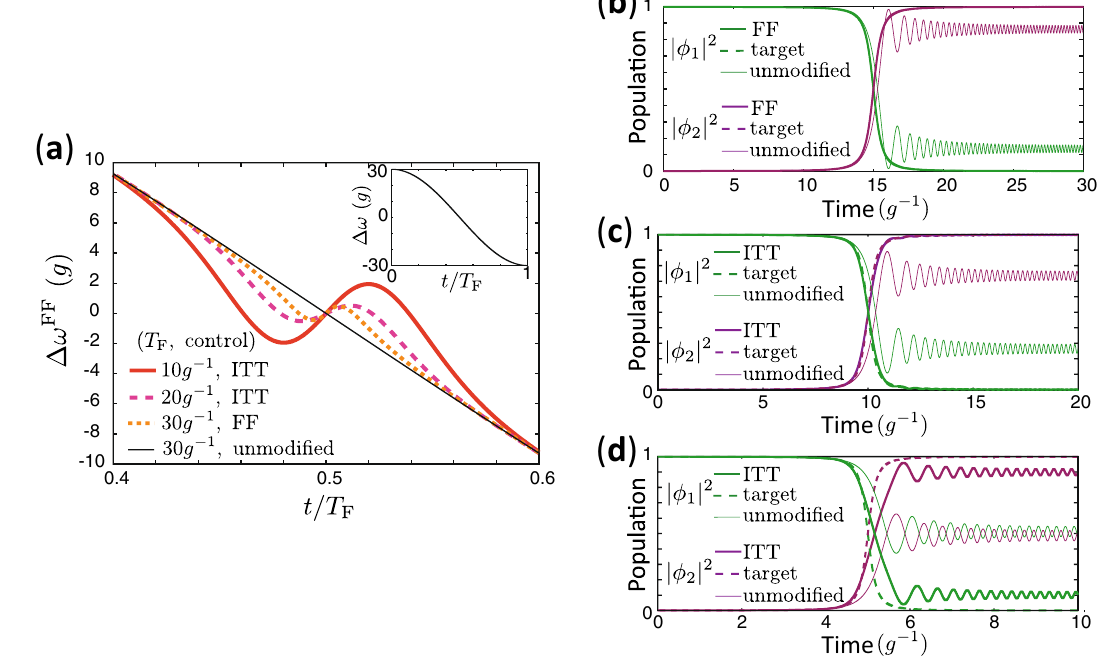
Figure 4. Time dependence of qubit resonance frequency and populations. ( a ) Time dependence of �ω for the unmodified control with T F = 30 g − 1 (thin black solid curve), �ω FF for FFST with T F = 30 g − 1 (orange dotted curve), �ω FF for ITT with T F = 20 g − 1 (pink dashed curve) and T F = 10 g − 1 (red solid curve). ( b ) Time dependence of the population of | m � in the unmodified control and the control with FFST for T F = 30 g − 1 . The corresponding speed-controlled trajectory is shown in Fig. 3a,d. The population of | m � in the target dynamics, | φ m (ω m ( t )) | 2 , is also shown. The curves for the target dynamics are overlapping with the ones for FFST. ( c,d ) Time dependence of the population of | m � for the unmodified control and ITT in Fig. 3e,f. The populations in the target dynamics are also